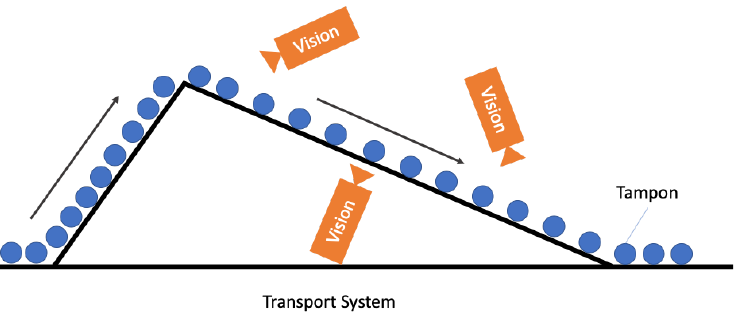
Figure 3. Schematic of the inspection unit.